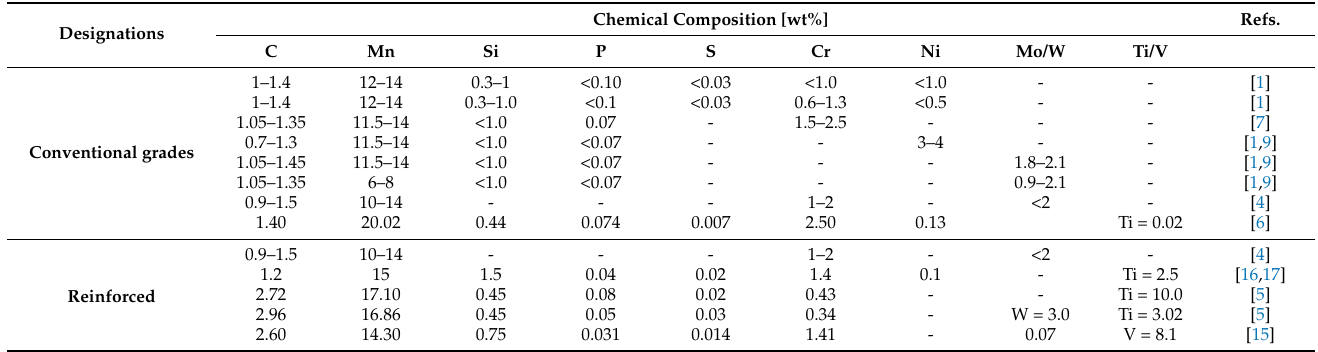
Table 1. Chemical composition of Hadfield cast steels for operation under the conditions of wear and